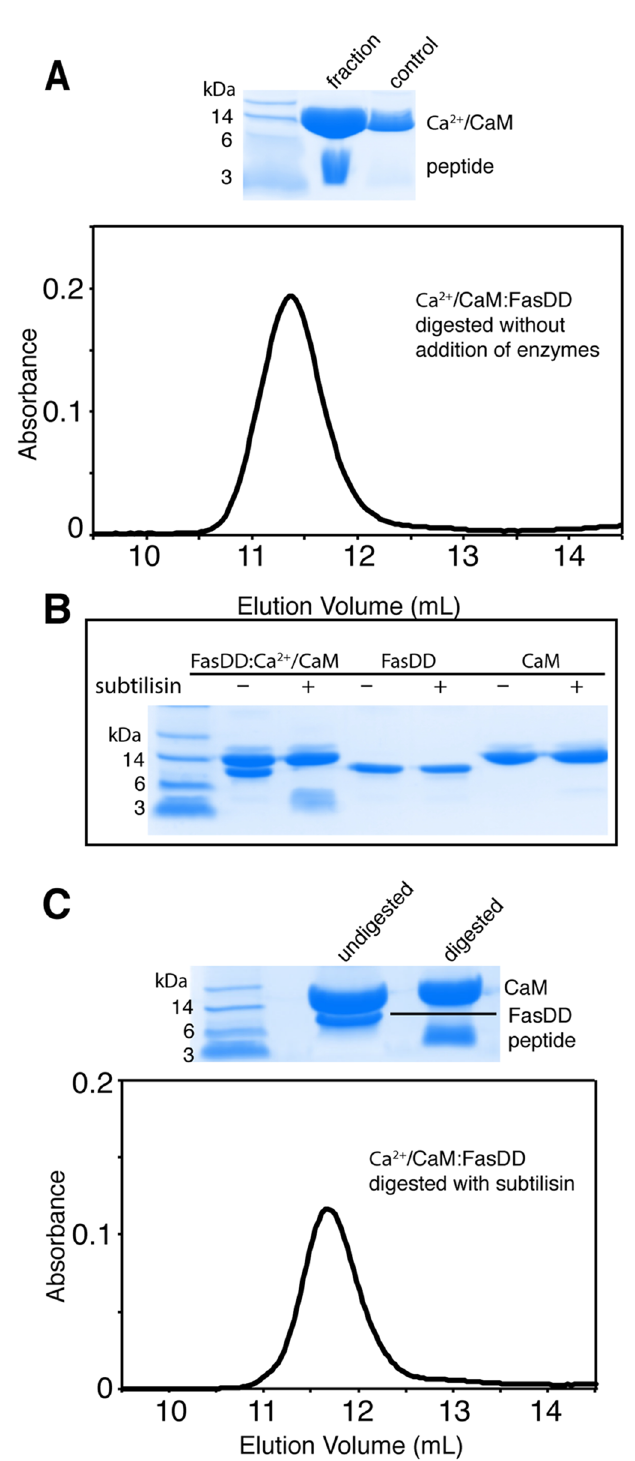
Fig 2. Proteolysis assay and gel filtration of Ca 2+ /CaM – FasDD digests. ( A ) Gel filtration and SDS-PAGE of the proteolysis product of a 2:1 Ca 2+ /CaM:FasDD sample left at 4°C for one week. The SDS-PAGE data show that the degraded FasDD protein gave rise to ~5 kDa fragment(s). The Ca 2+ /CaM protein, however, remained stable. Analysis of the digestion products by mass spectrometry confirmed the identity of the FasDD peptides that are resistant to proteolysis. The most abundant peptides are located in the N-terminus (205 – 238, 205 – 239, and 205 – 240) and in the C-terminus (251 – 288, 259 – 288 and 262 – 288). ( B )